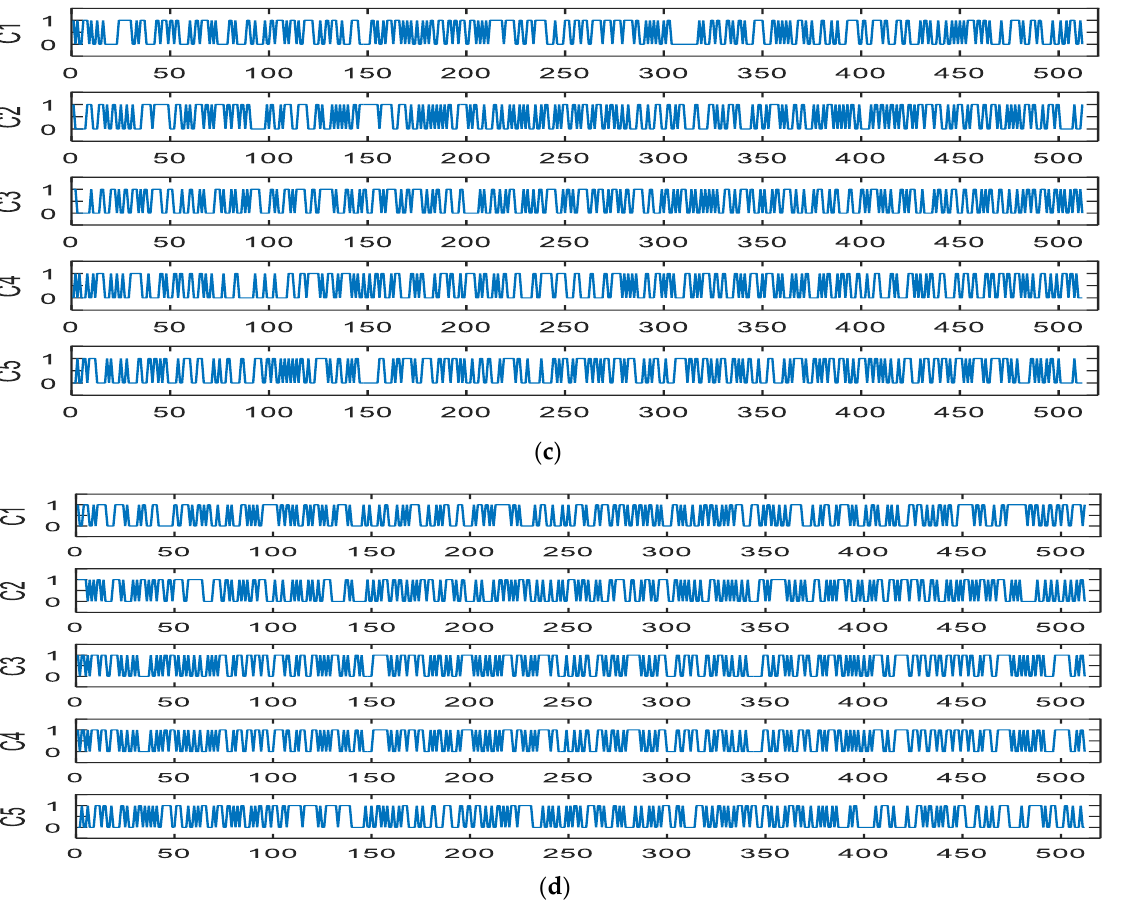
Table 5. Hash values of second structure.